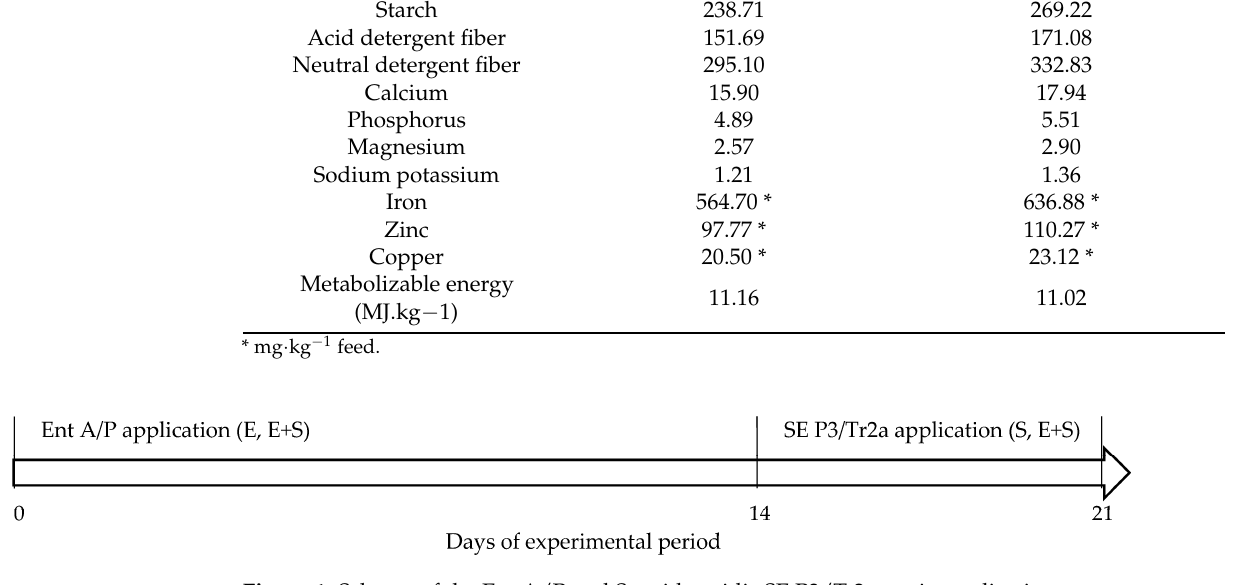
Figure 1. Scheme of the Ent A/P and S. epidermidis SE P3/Tr2a strain application